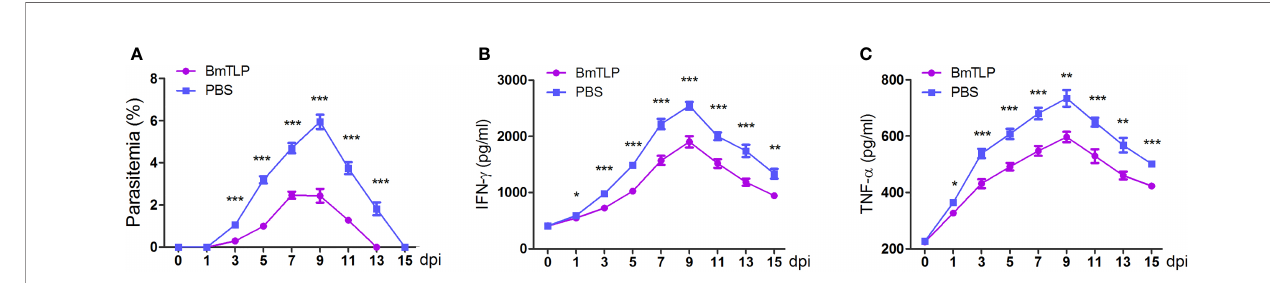
FIGURE 5 | Immunization with recombinant Bm Trx-like protein ( Bm TLP) protected mice against B. microti infection. His-tagged Bm TLP or PBS was used to immunize BALB/C mice (seven mice per group). After successful immunization, a challenge with 1 × 10 6 B. microti- infected red blood cells was implemented. Parasitemia (A) was examined with tail blood by performing Giemsa staining and IFN- g (B) and TNF- a (C) in mice serum were detected by ELISA 0, 1, 3, 5, 7, 9, 11, 13, and 15 days post-infection (dpi). The results are representative of two independent experiments. Data indicate the mean ± standard deviation. Asterisks indicate comparison between the two groups at each time point with * p < 0.05, ** p < 0.01, and *** p